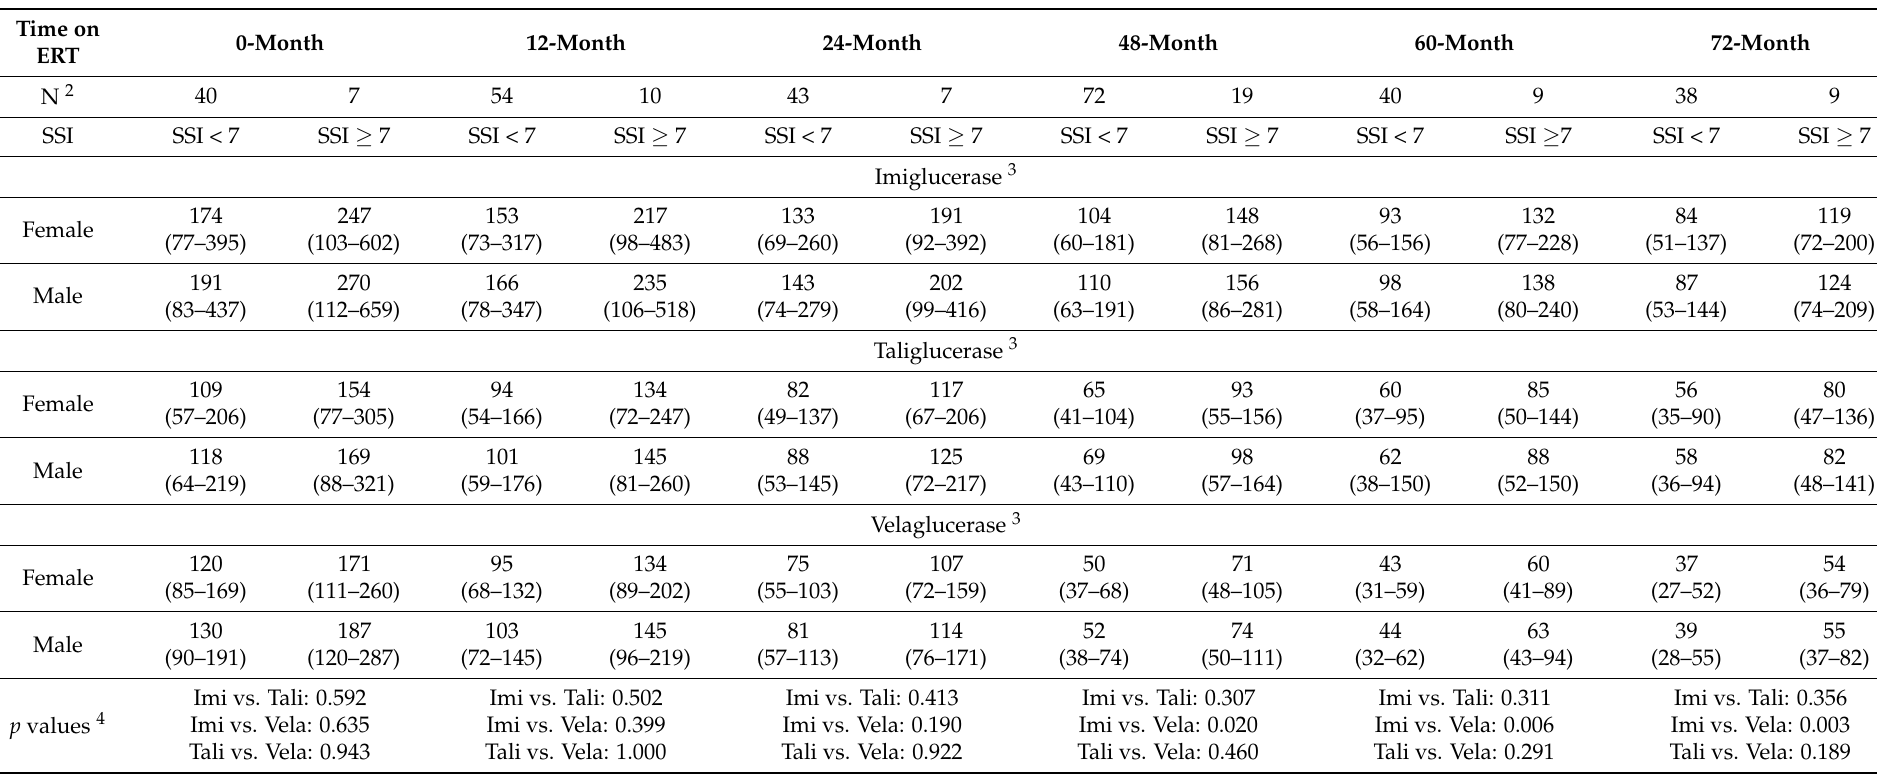
ERT, enzyme replacement therapy; SSI, severity score index; Imi, Imiglucerase; Tali, Taliglucerase alfa; Vela, Velaglucerase alfa. 1 Model: a linear mixed model with a random intercept for individuals (135 individuals, 617 measures). Dependent variable: lyso gb1 log-transformed, independent variables: age at the first observation time-point, sex, ERT (Imiglucerase, Taliglucerase, Velaglucerase), SSI at baseline categorized (cut off 7), dosage, severity according to genotype, time on ERT; and therapy was entered as interaction term and with using natural cubic splines for the time on ERT with two degrees of freedom. 2 For calculating the number of measurements, the following periods were used: 0: 0–3 month, 12: 4–12 month, 24: 13–24 month, 48: 25–48 month, 60: 49–60 month, 72: 61–72 month, additionally 269 measures of 73+ months were used in the model. 3 model-based marginal means and 95%CI (back-transformed form log-transformed values). 4 adjusted within each time point according to Tukey’s